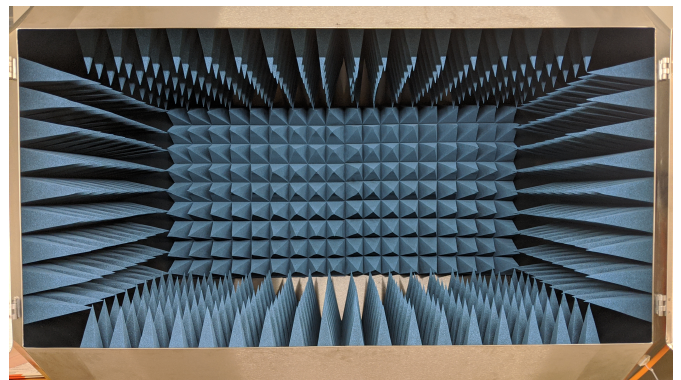
Figure 12. Realized anechoic